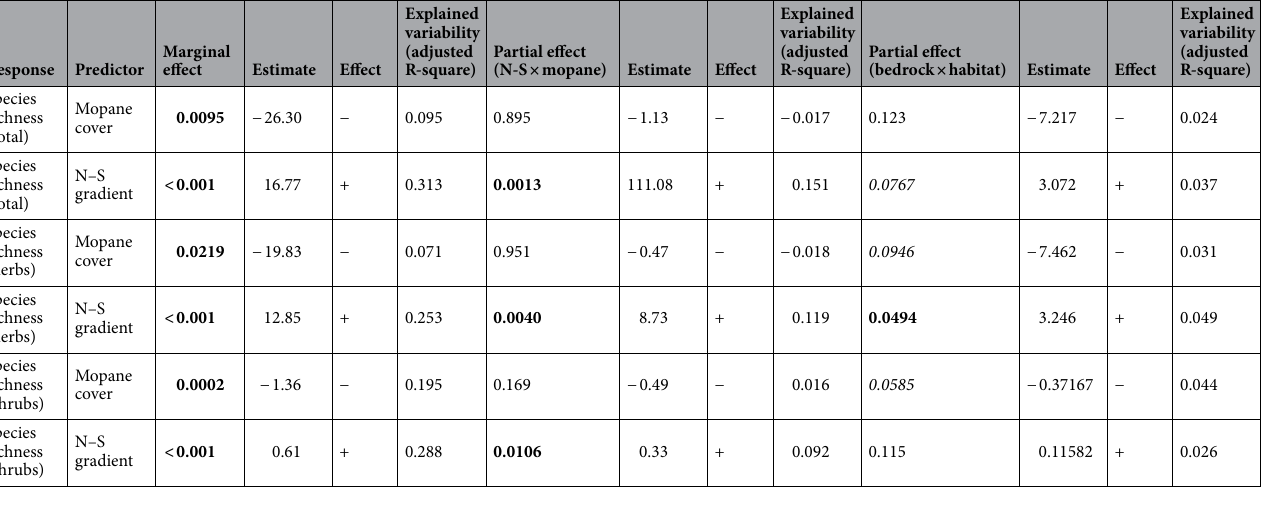
Table 5. The results of variance partitioning between the effects of mopane ( Colophospermum mopane ) cover and the north–south (N–S) gradient in the Kruger National Park on plant species richness. The marginal effects represent the coarse effects, without accounting for the confounded factors, while partial effects represent the net effects after accounting for the confounded factors. Significant effects are in bold, marginally significant in italics, the direction of the effect is indicated by the plus/minus